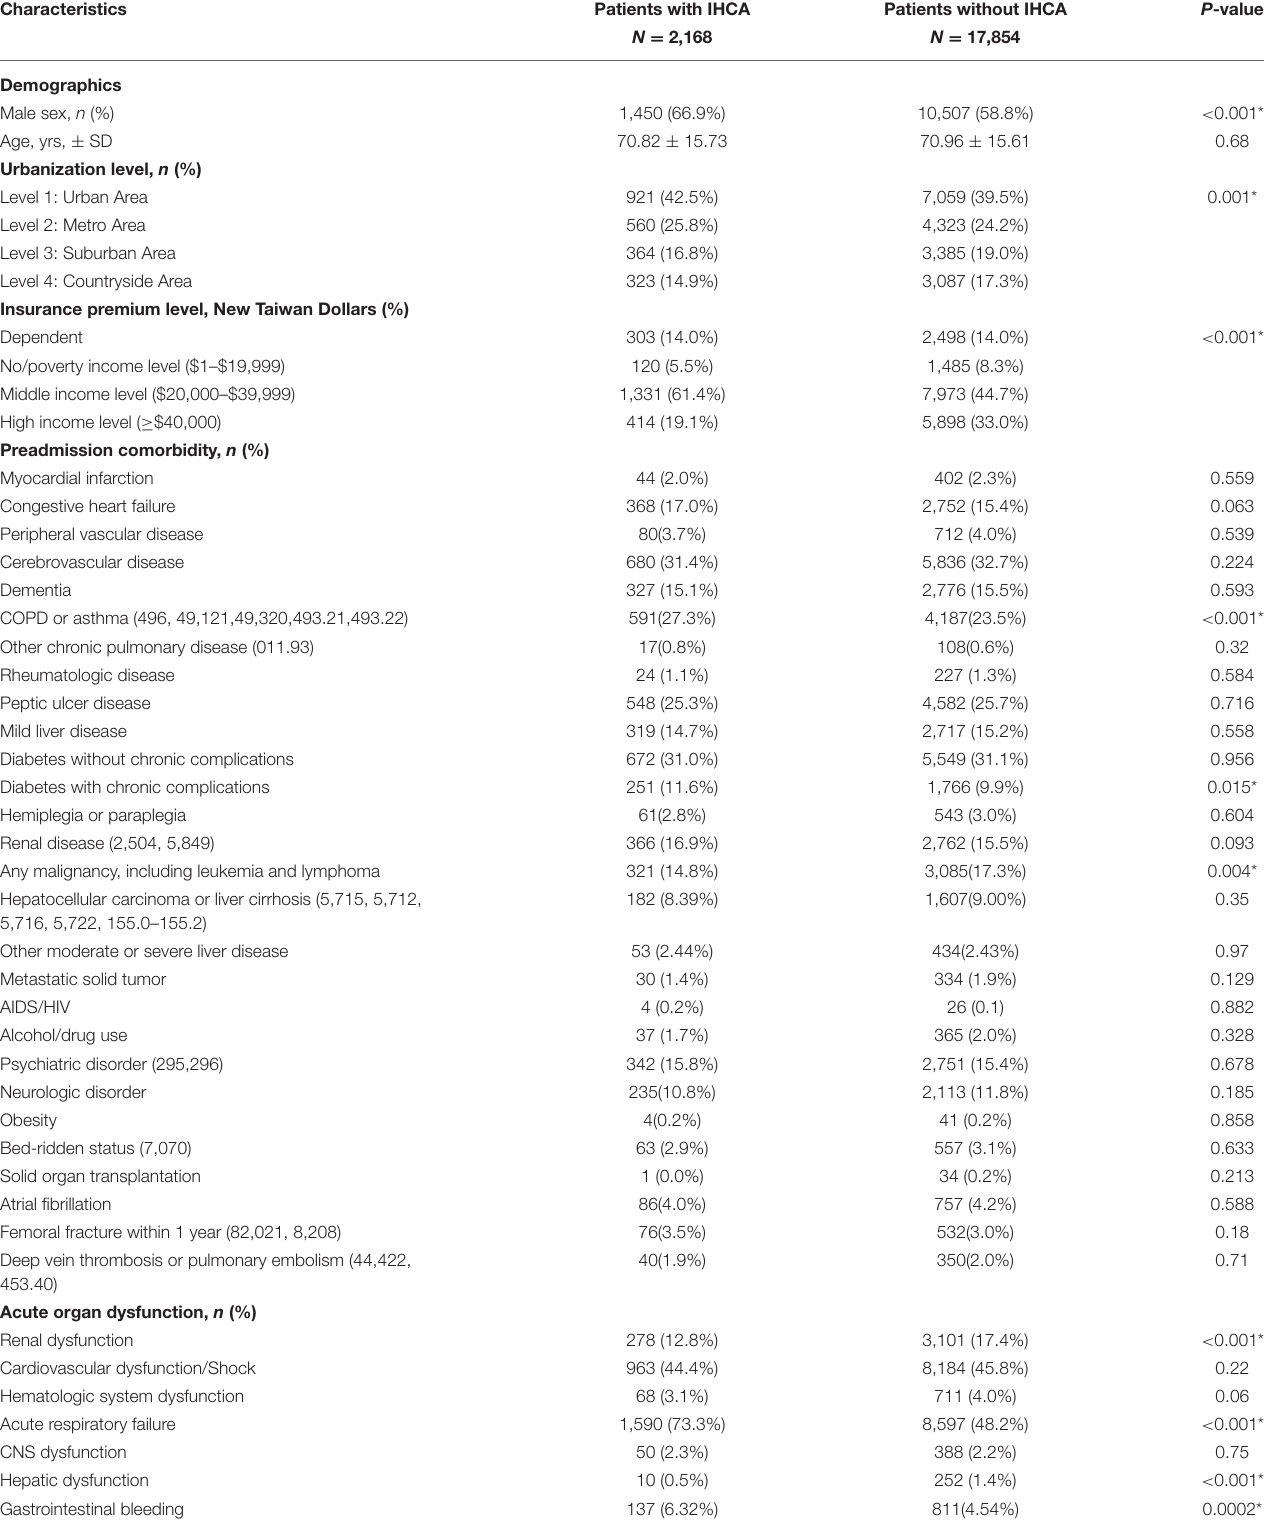
TABLE 1 | Comparison of patient characteristics between patients with and without post-sepsis cardiovascular complications at the end of 180 days of follow-up. Characteristics Patients with IHCA Patients without